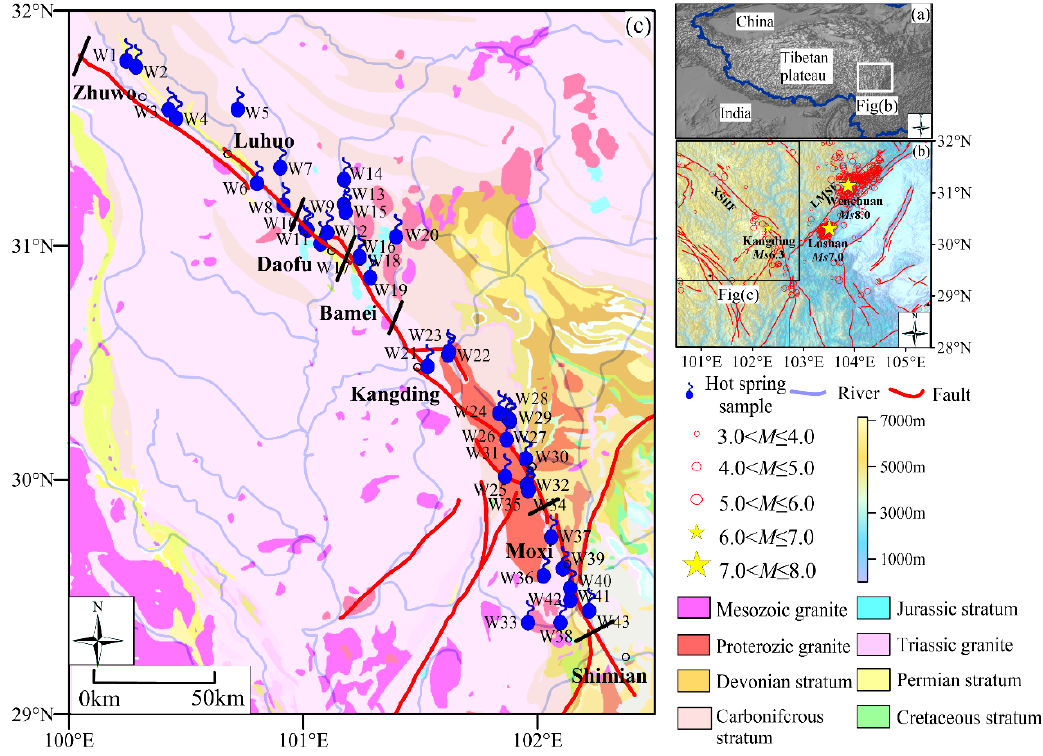
Figure 1. The plot of sampling site distribution. ( a ) Localization of the area of this study; ( b ) Topographic map in the XSHF. XSHF: Xianshuihe fault; LMSF: Longmenshan fault; ( c ) Geological map in the XSHF.